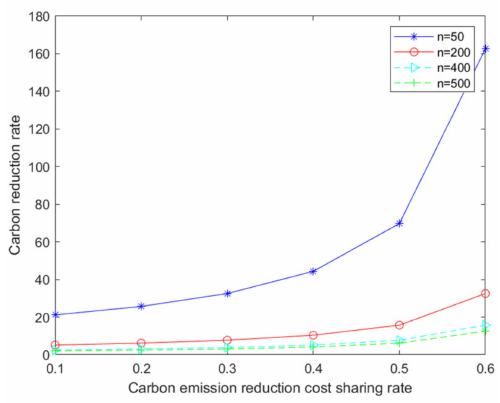
Figure 10. In the condition of centralized decision making in the supply chain with government carbon subsidies and supply chain carbon emission reduction cost sharing, the impact of the retailer carbon emission reduction cost-sharing rate on the carbon emission reduction rate is